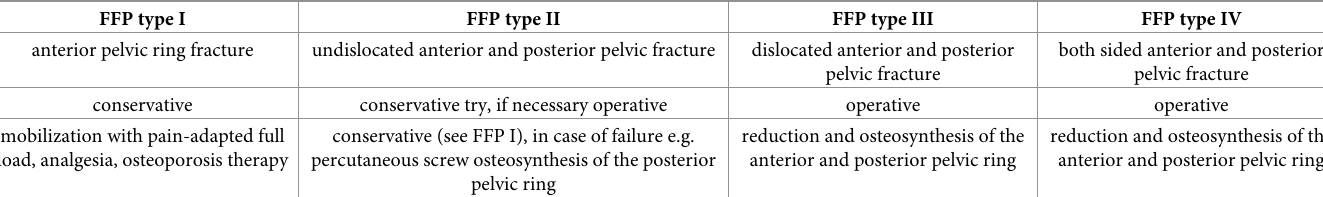
Table 1. Overview of the fracture location and therapeutic regime recommended by Rommens et al.